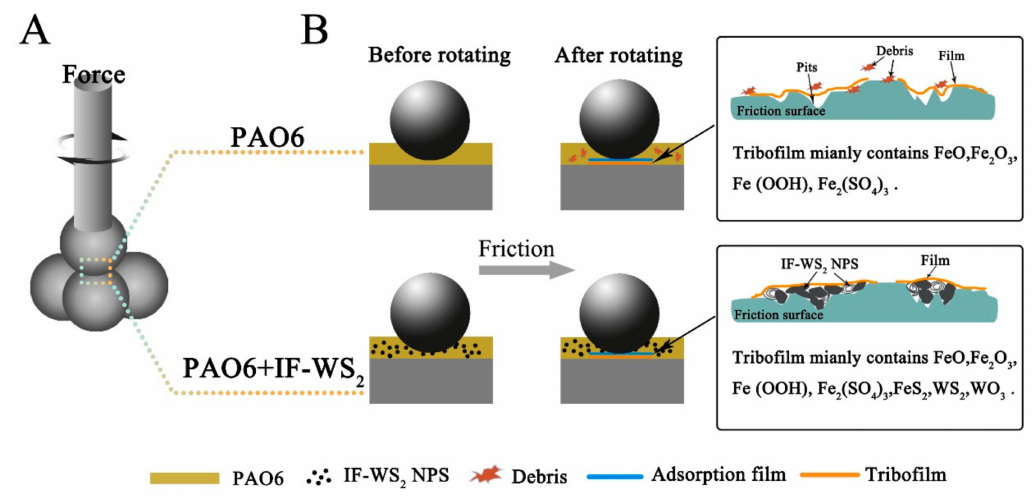
Figure 1. A schematic of ( A ) the four-ball friction tester used in this study, and ( B ) the possible lubrication mechanism of IF–WS 2 in the PAO6